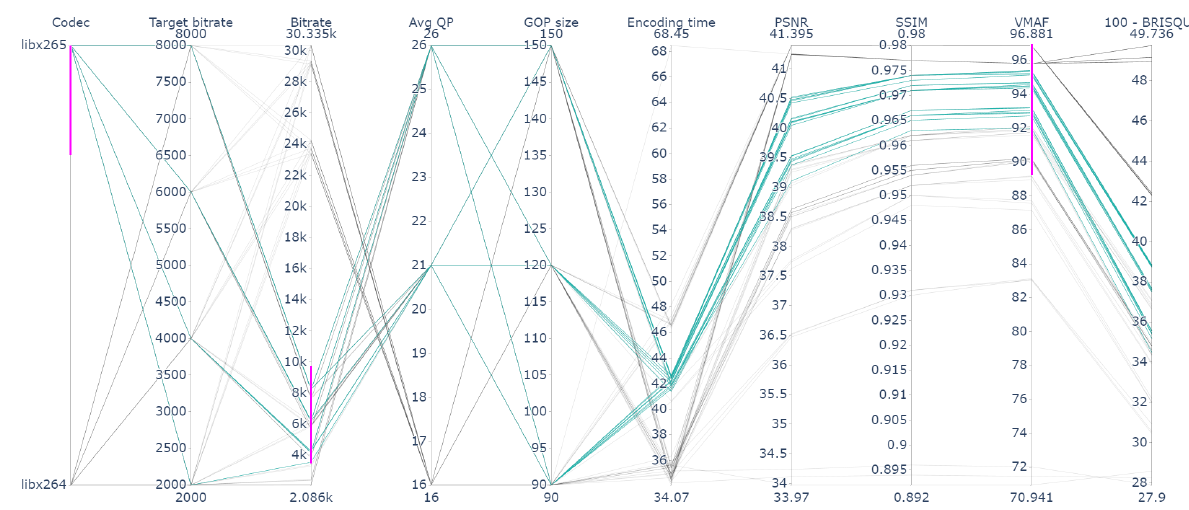
Figure 8. x264 filtered purple color parallel coordinates (filtered with magenta line).